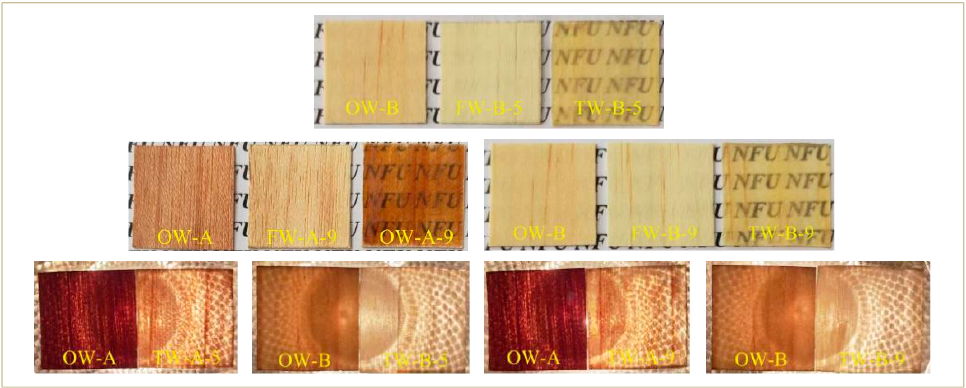
Figure 3. The color difference of OW, ( a ) FW and ( b ) TW.